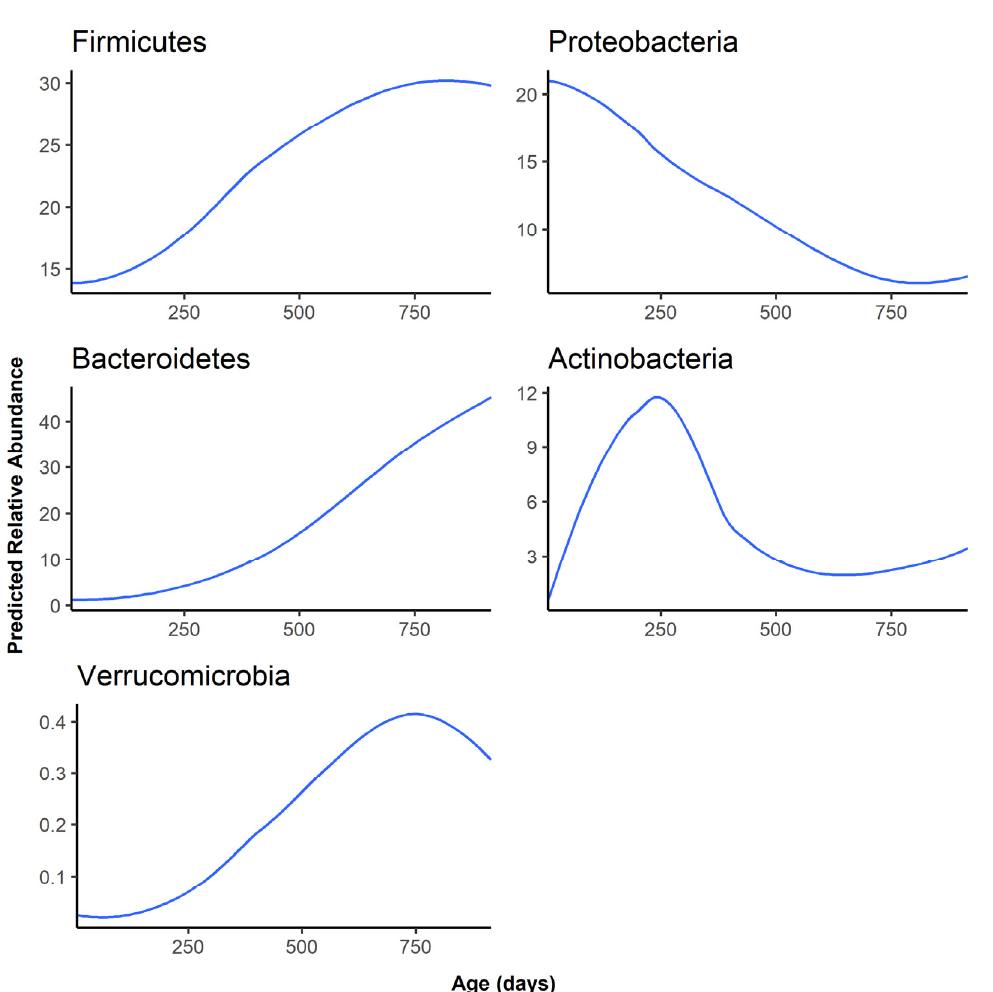
Figure 3. Predicted abundance over time for the top 5 most abundant phyla . The predicted relative abundance of each taxon is shown as a function of infant age.